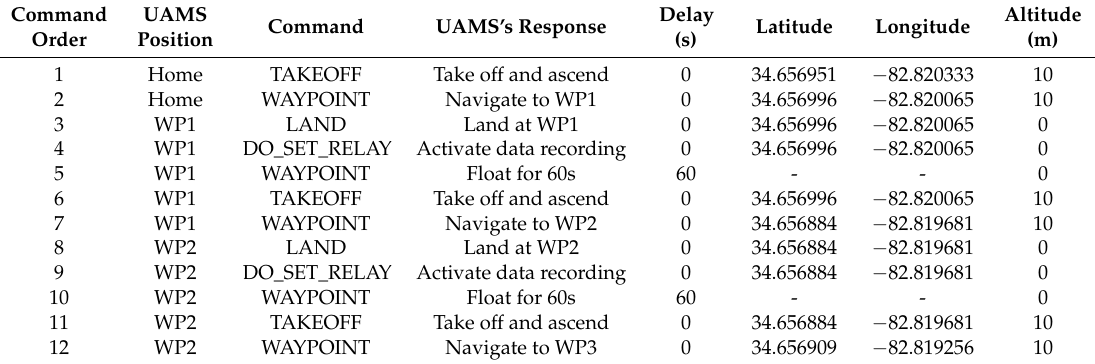
Figure 4. Applied method of water quality measurement using the UAMS. Table 1. Autonomous navigation commands used for the UAMS mission flight.